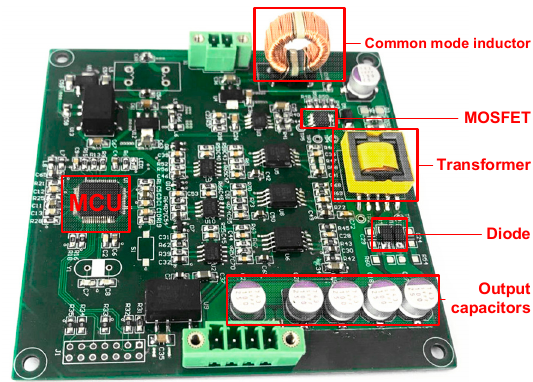
Figure 14. Photograph of the experimental prototype.